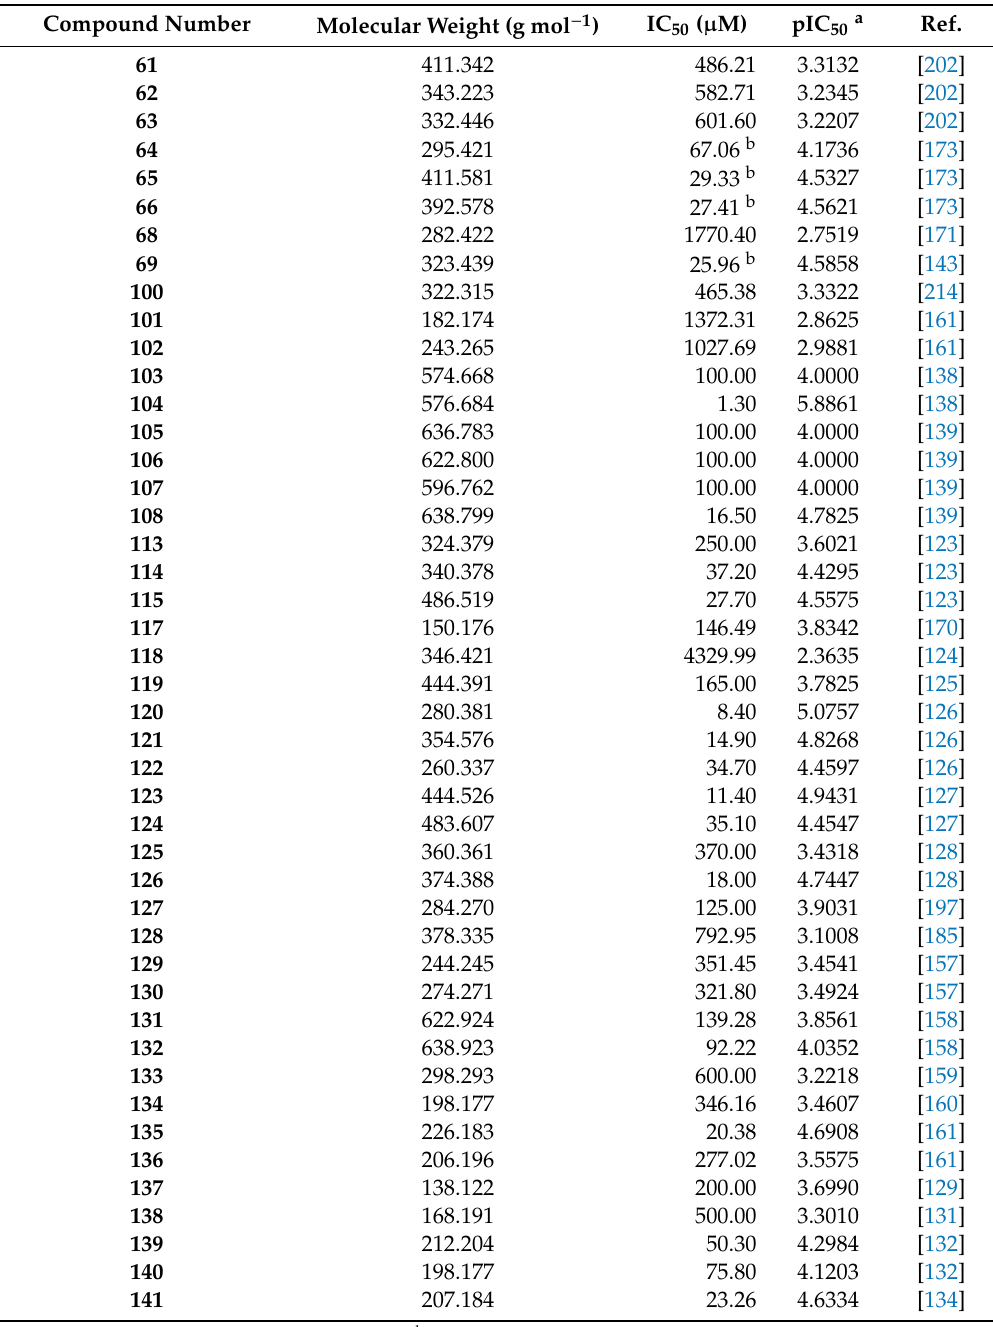
Table 4. Antioxidant capacity of Streptomyces -derived